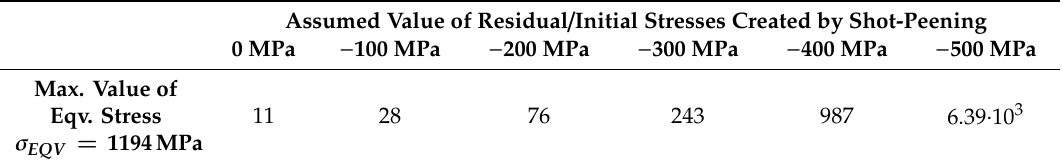
Table 1. Results of the numerical fatigue analysis based on the equivalent stress at the notched edge, with an amplitude of resonant vibrations of 1.8 mm.